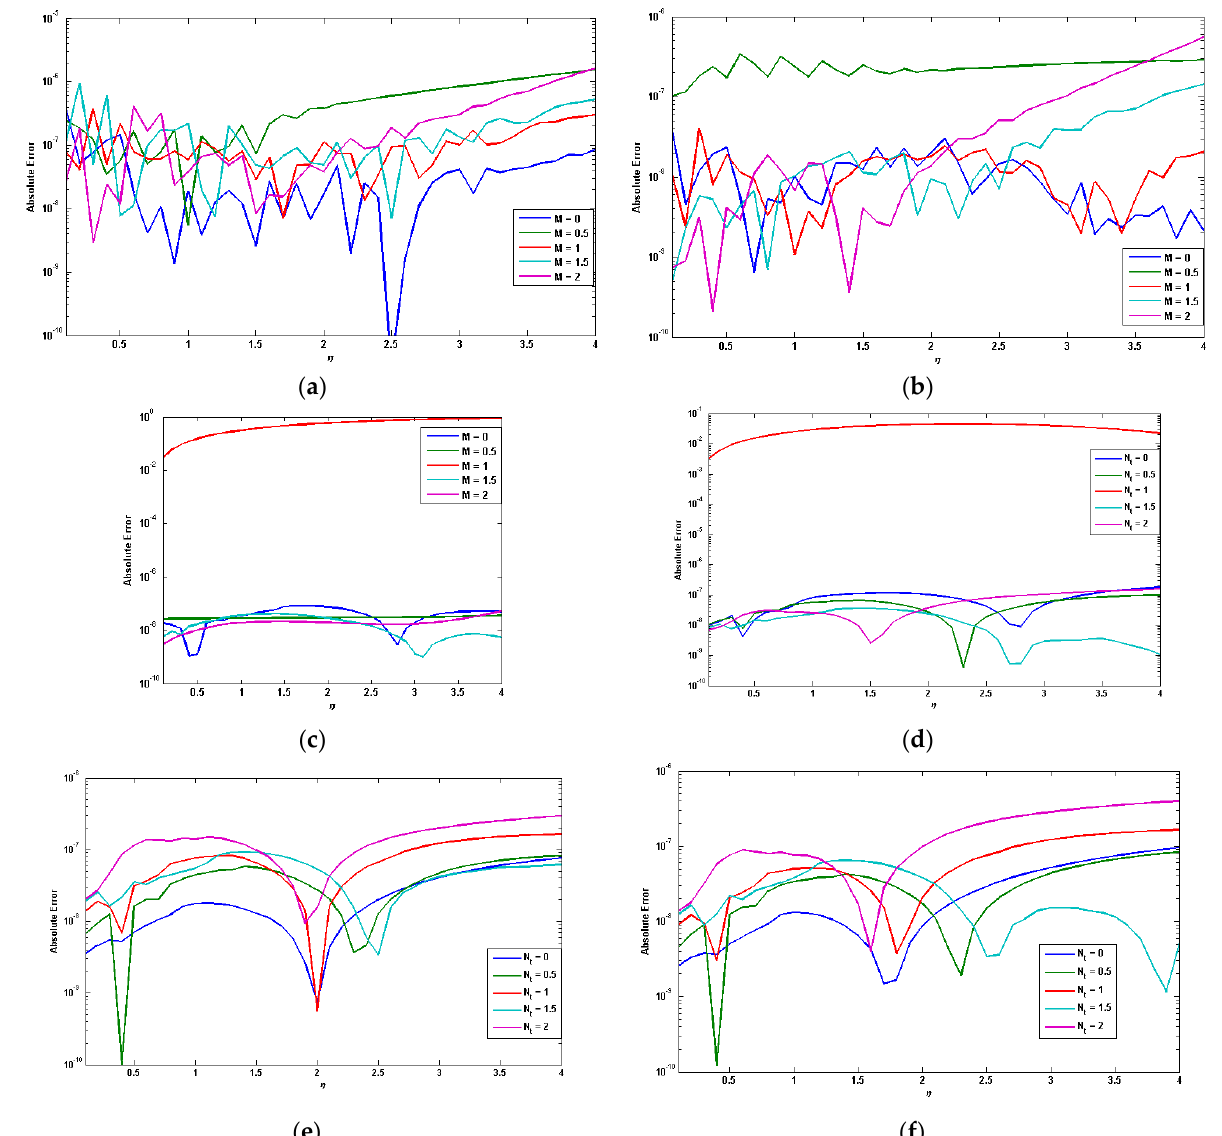
( ) f ¢ h ( ) f h ( ) x h Figure 2. Behavior of absolute error in ( a ) f (cid:48) ( η ) for magnetic parameter, ( b ) φ ( η ) for magnetic parameter, ( c ) ξ ( η ) for Figure 2. Behavior of absolute error in ( a ) for magnetic parameter, ( b ) for magnetic parameter, ( c ) magnetic parameter, ( d ) θ ( η ) for thermophoretic parameter, ( e ) φ ( η ) for thermophoretic parameter, and ( f ) ξ ( η ) for ( ) q h ( ) f h for magnetic parameter, ( d ) for thermophoretic parameter, ( e ) for thermophoretic parameter, and ( f ) thermophoretic ( ) x h for thermophoretic parameter .